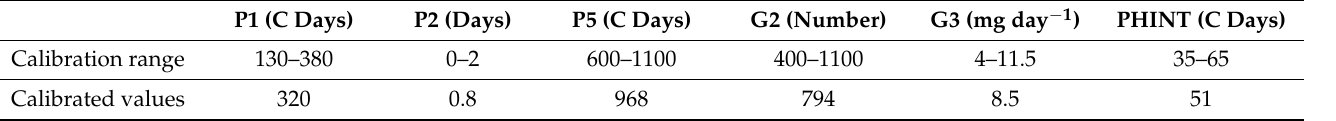
Table 1. Calibrated values of cultivar-specific parameters for medium-maturity maize variety (CV, SC10) in the DSSAT-CERES-Maize model (v. 4.7.5) for maize experiments in Ismailia, Egypt.